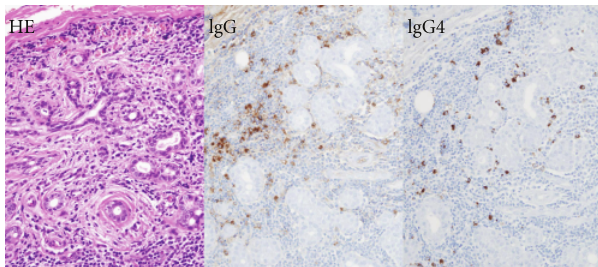
Figure 2: Histopathology of a patient with limited stage IgG4- related dacryoadenitis. A 35-year-old woman presented with swelling of her bilateral lacrimal glands. Her serum IgG and IgG4 concentrations were 1,149 mg/dL and 125 mg/dL, respectively, and her serum IgG4/IgG ratio was 10.88%. Histopathological examination of a lacrimal gland biopsy revealed IgG4+ plasma cell infiltration, with an IgG4+/IgG+ cell ratio of 74.7%, and 53 IgG4+ cells per HPF, although sclerotic changes were not severe. Treatment with prednisolone 20 mg/day resulted in a rapid and dramatic improvement in symptoms. Although using an absolute serum IgG4 cuto ff concentration of > 135mg did not result in diagnosis of IgG4- RD, her clinical course and histopathology were typical of IgG4- RD. However, using a serum IgG4/IgG ratio > 8% as a cuto ff value resulted in a diagnosis of